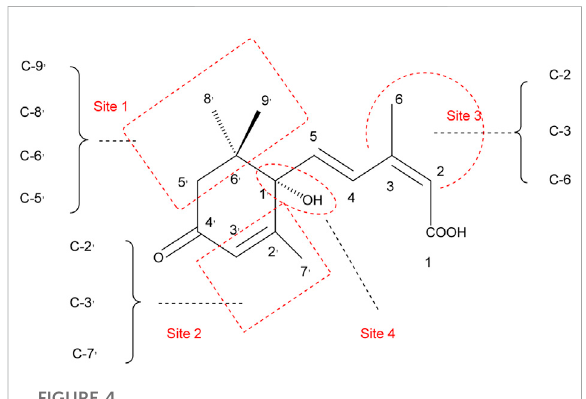
FIGURE 4 Modi fi cation sites of abscisic acid structural